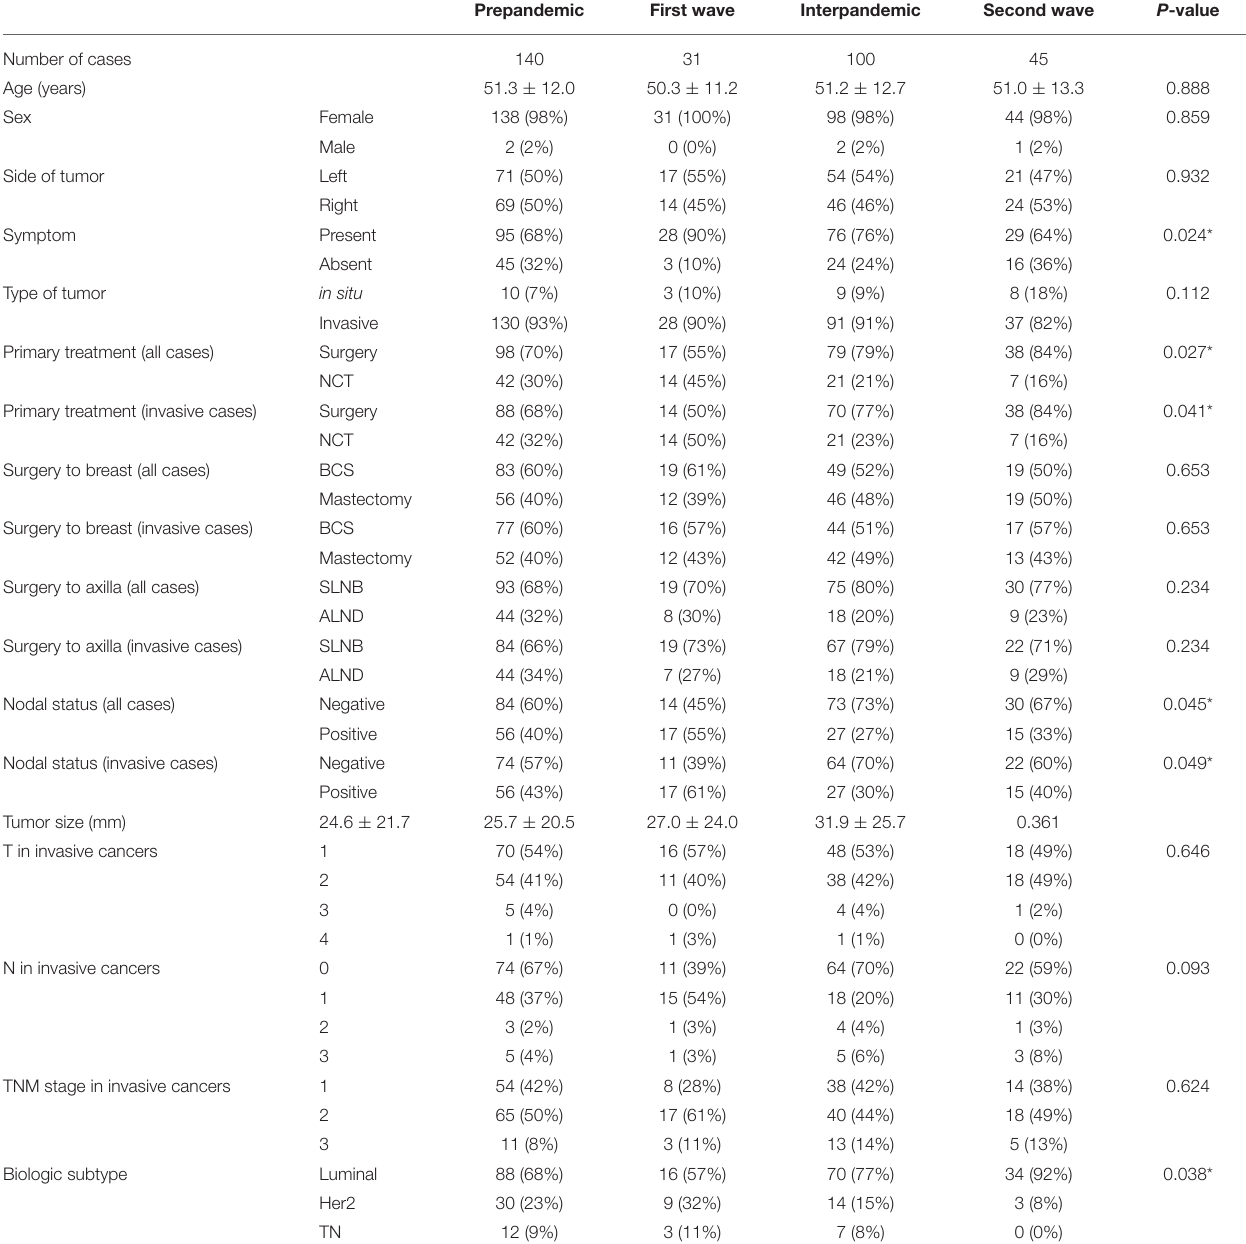
TABLE 1 | Characteristics of the patients according to the